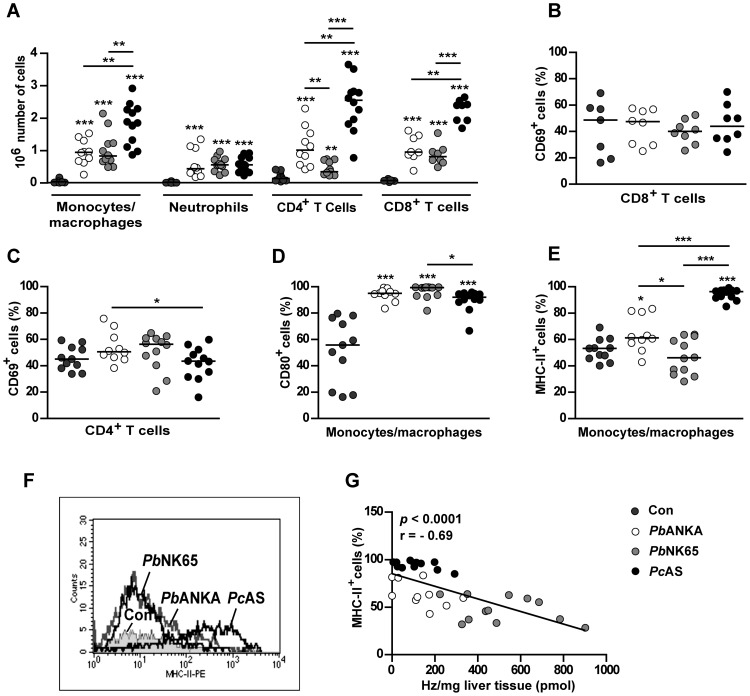
Inflammatory cell recruitment to the liver.C57BL/6J mice were left uninfected (Con) or were infected with PbANKA, PbNK65 or PcAS and hepatic leukocytes were analyzed 8 (PbANKA) or 10 (PbNK65, PcAS) days after infection by flow cytometry. (A) Total numbers of monocytes/macrophages (F4/80+CD11b+), neutrophils (F4/80−CD11b+Gr-1+), CD4+ T cells and CD8+ T cells in the liver. Proportion of CD8+ T cells (B) or CD4+ T cells (C) expressing the early activation marker CD69. Proportion of monocytes/macrophages expressing CD80 (D) or MHC class II (E). Data are pooled from three separate experiments with similar results. (F) Histogram showing the MHC-II expression on F4/80+CD11b+ cells from Con, PbANKA, PbNK65 or PcAS-infected mice. (G) Spearman correlations between hepatic hemozoin (Hz) amounts and the proportion of monocytes/macrophages expressing MHC class II in infected mice. Spearman r and p-values are indicated.